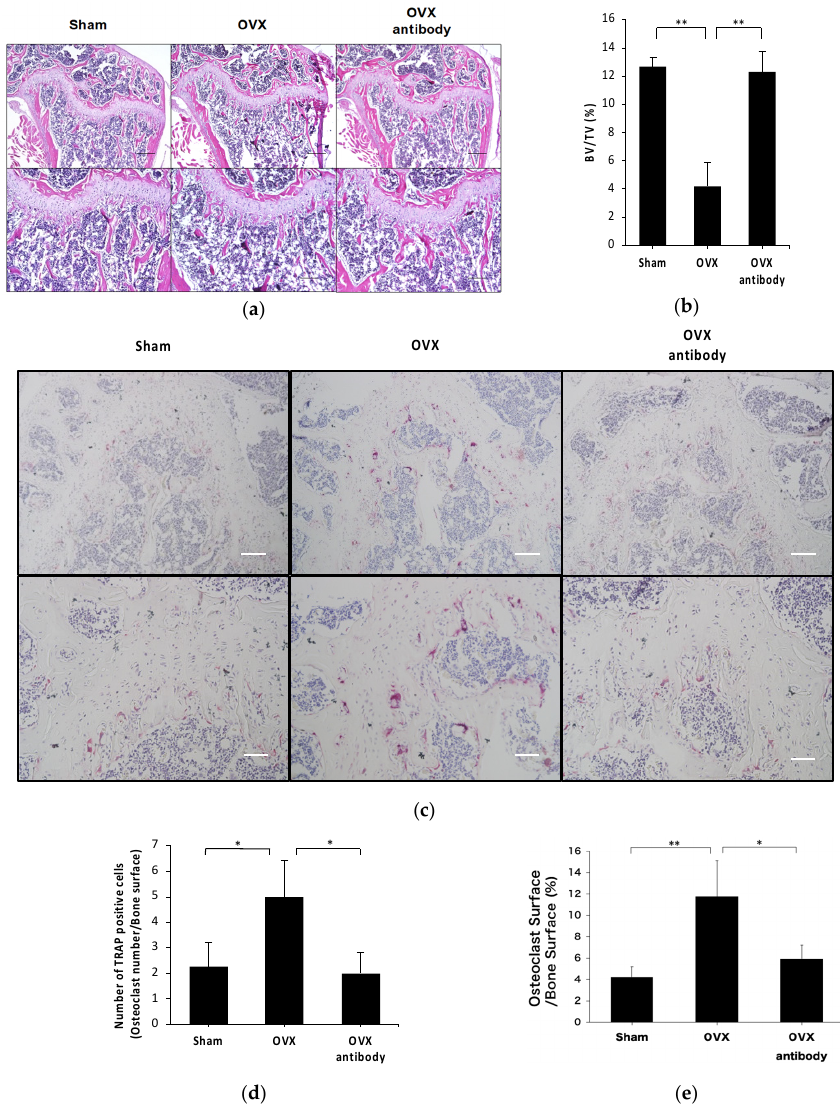
Figure 4. Anti-c-fms antibodies inhibited osteoclast formation in OVX mice. ( a ) Representative images of HE-stained distal femurs of OVX mice, OVX mice treated with anti-c-fms antibody and sham mice. Scale bar = 200 µ m; scale bar = 100 µ m in the enlarge pictures. Quantitative analysis of ( b ) BV / TV was performed using image J. ( c ) Representative images of TRAP-stained distal femurs in OVX mice, OVX mice treated with anti-c-fms antibody and sham mice. Scale bar = 100 µ m; scale bar = 50 µ m in the enlarged pictures. Quantitative analysis of ( d ) N.Oc / BS and ( e ) Oc.S / BS was performed using image J. Data are expressed as the mean ± standard deviation (SD). Statistical significance of di ff erences between groups was determined using Sche ff e’s test ( n = 4; ** p < 0.01 * p <